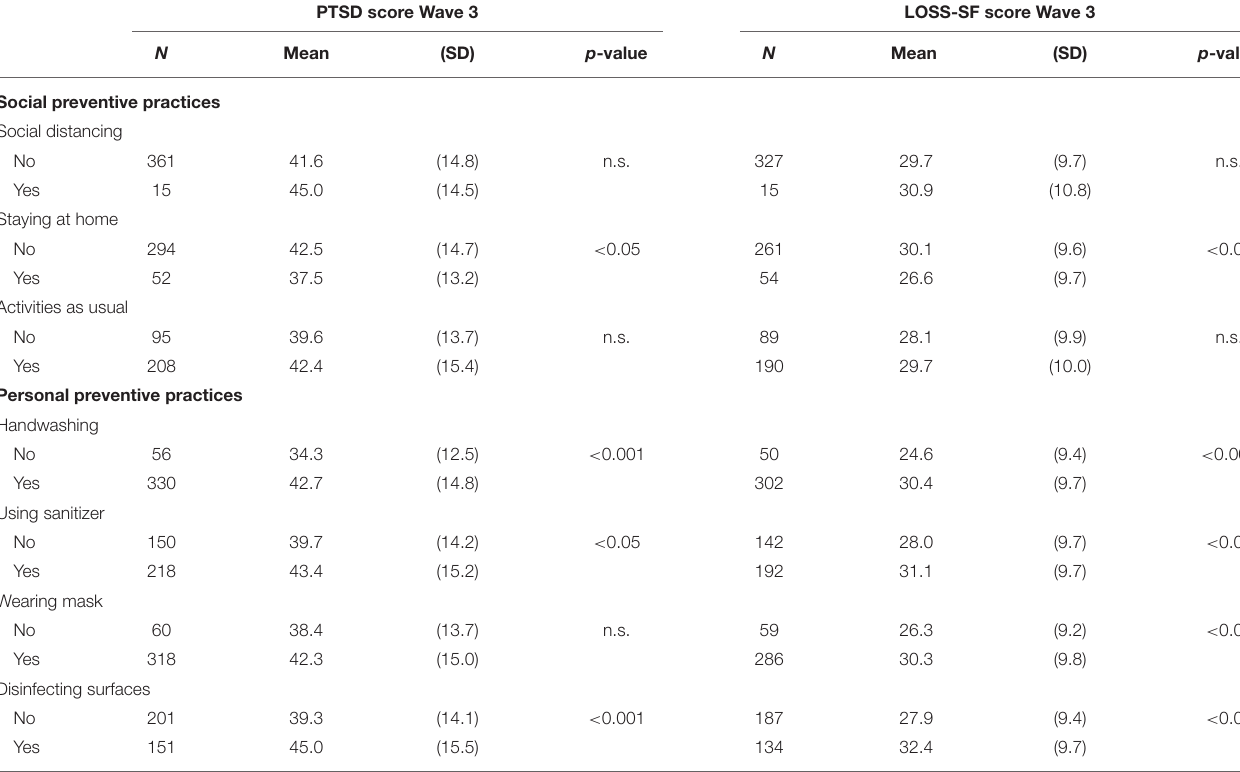
TABLE 4 | Mean scores (SD) of PTSD at Wave 3 and LOSS-SF according to social and personal preventive